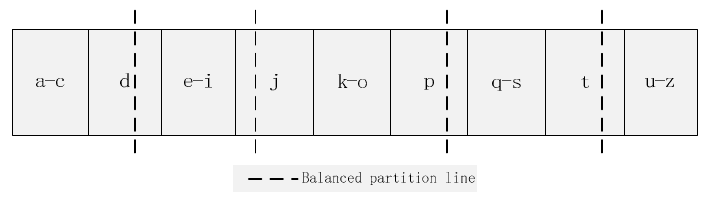
Figure 2. Balanced Figure 2. Balanced Partition.